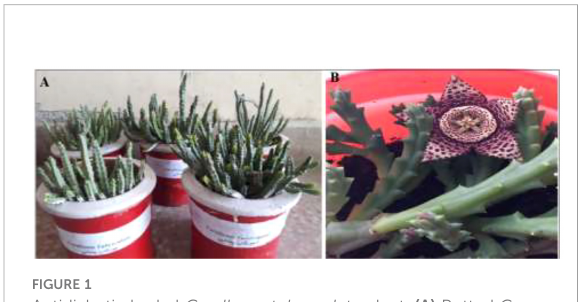
FIGURE 1 Antidiabetic herbal Caralluma tuberculata plant. (A) Potted C tuberculata . (B) C tuberculata fl